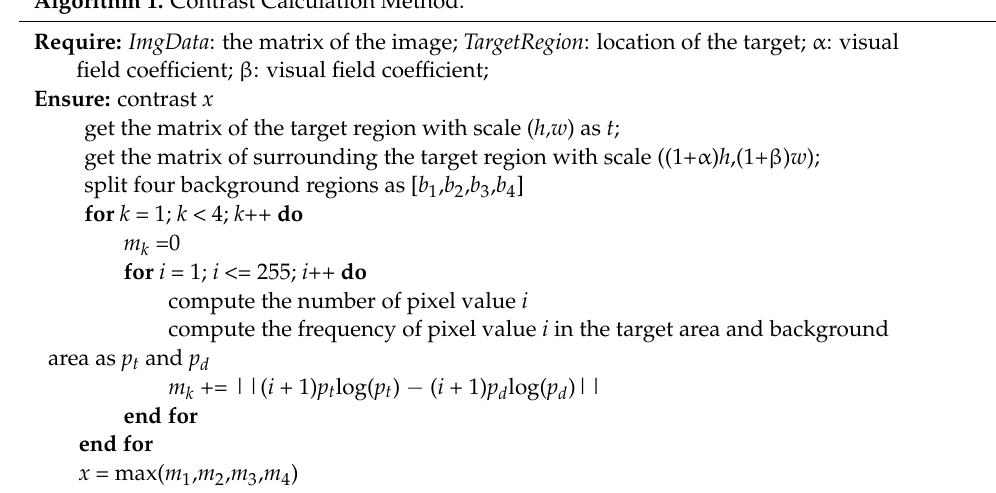
Algorithm 1. Contrast Calculation